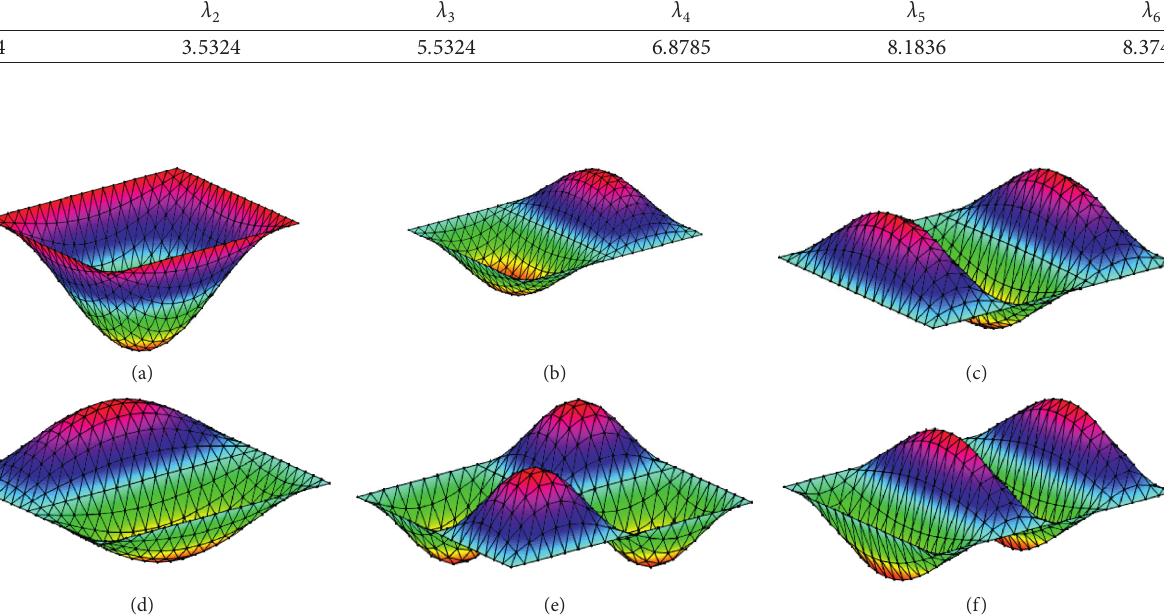
Figure 7: The first six mode shapes of the FGP plate on EFTIM. (a) Mode 1. (b) Mode 2. (c) Mode 3. (d) Mode 4. (e) Mode 5. (f) Mode